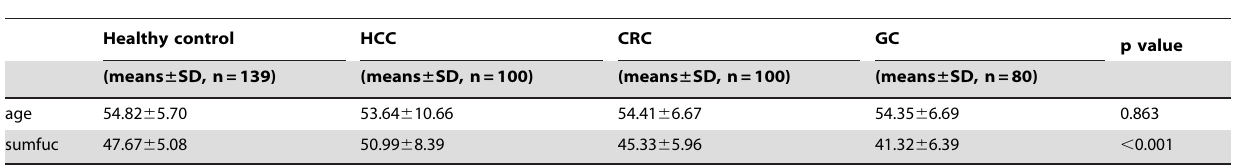
Table 5. N-glycome analysis in digestive system cancers